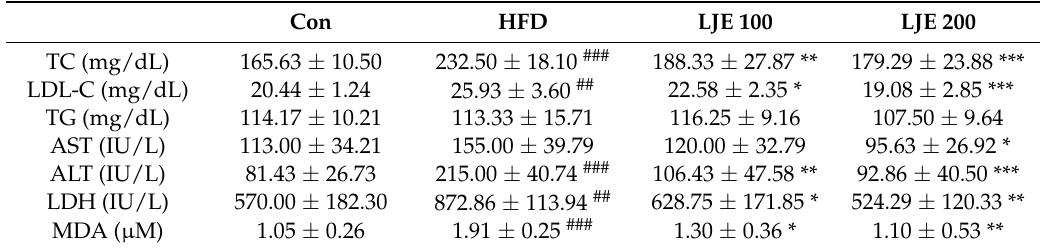
Table 2. Effects of LJE on serum biochemical parameters in HFD-fed mice.